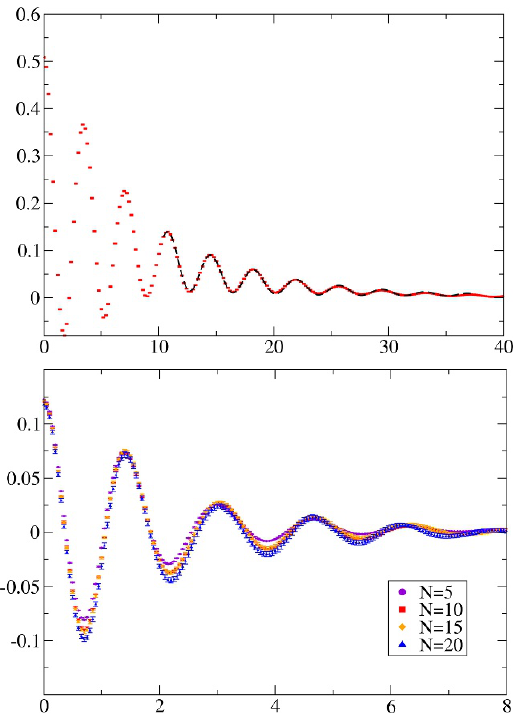
Figure 5 . Top panel: the behavior of hN 2 i ( t (cid:0) t quench ) for an edge-type quench, with h = 0 : 6, (cid:15) = 0 : 25, and N = 15. The solid curve is the lowest quasinormal mode obtained from our (cid:12)t procedure. Bottom panel: the behavior of hN 2 i ( t (cid:0) t quench ) for an in(cid:13)ation-type quench, various values of N , h = 0 : 1, and (cid:15)N = 0 :